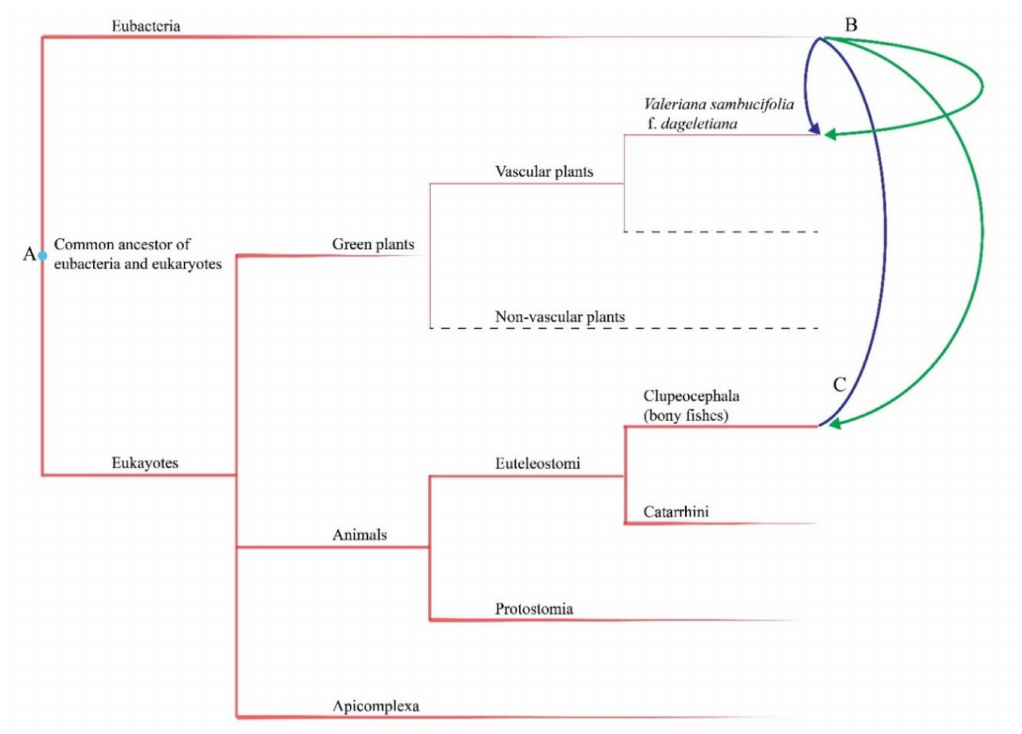
Figure 7. Three scenarios proposed to explain the occurrence of sequence region similarity between the plastome of Valeriana sambucifolia f. dageletiana and the nuclear genome of bony fishes. ( A ) Vertical inheritance from a common ancestor of eukaryotes and bacteria. ( B ) Independent gene transfer from bacteria. ( C ) Horizontal gene transfer from bony fishes to V. sambucifolia f. dageletiana via